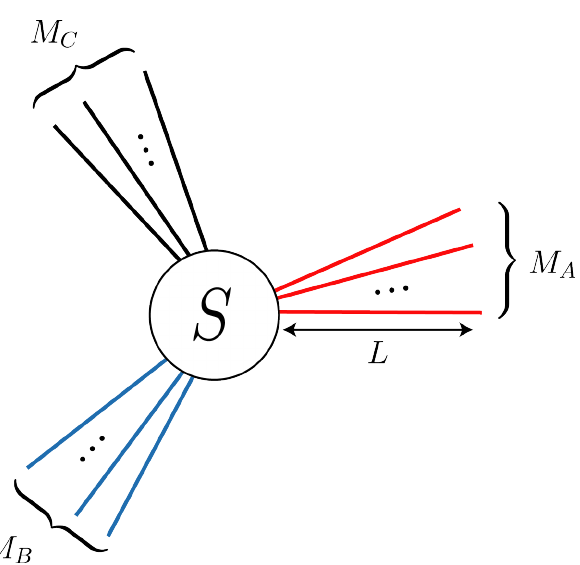
Figure 1 . The conformal junction: M wires are joined together at x = 0 by a conformally invariant scattering matrix S . We consider a tripartition in three sets A, B, C with M The entanglement between A and B is given by the negativity (1.6). A bipartite configuration is simply obtained by letting M = 0 C